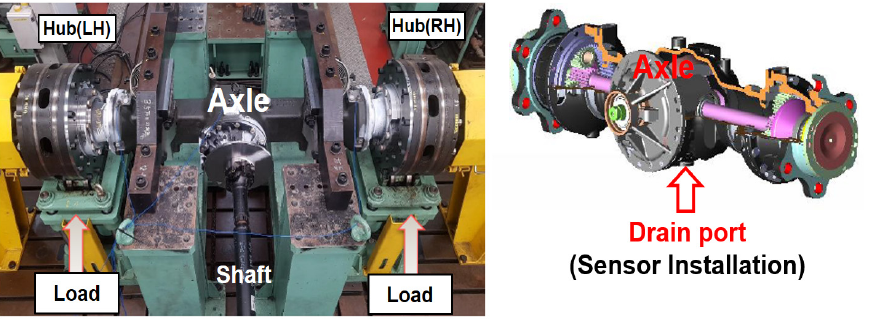
Figure 4. Bench test device of the axle.